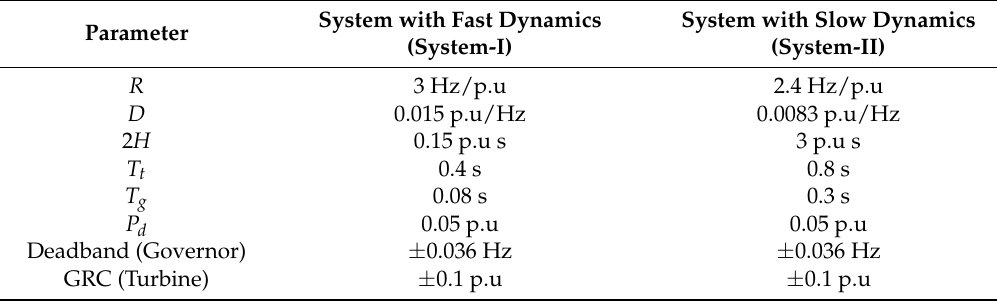
Table 1. Parameters of test systems with slow and fast dynamics [15].